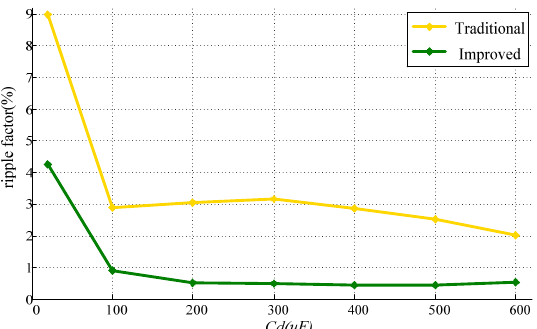
Figure 10. DC voltage ripple coefficient under traditional and improved modulation strategies.